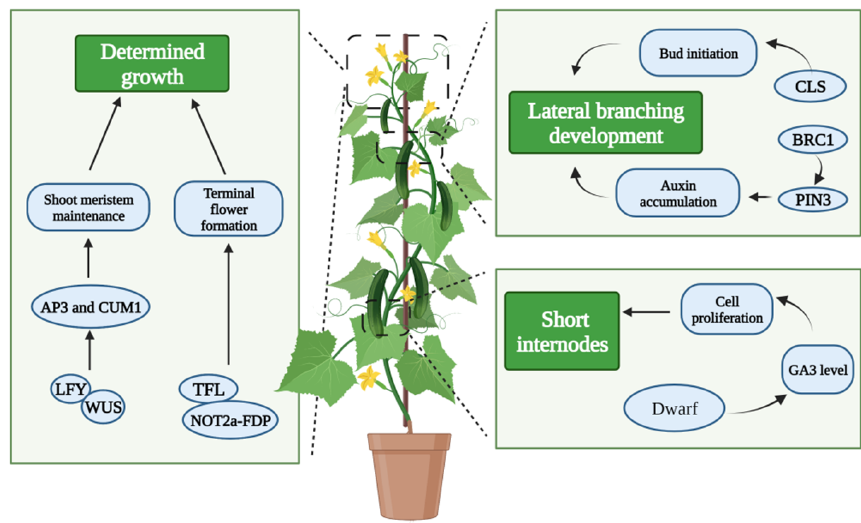
Figure 3. Genetic and molecular regulation mechanisms of the cucumber plant architecture. TFL1’s interaction with CsNOT2a-CsFDP impedes terminal flower formation, and LFY interacts with CsWUS to regulate shoot meristem maintenance in cucumber via activating CsAP3 and CsCUM1 to regulate cucumber towards a determined growth pattern. BRC1 regulates lateral branching by influencing auxin accumulation, while CLS influences bud initiation. Dwarf regulates the internodes by the regulation of endogenous GA3 levels and cell counts in the main stem. Abbreviations in figure, LFY: LEAFY; AP3: APETALA3; CUM1: Cucumber MADS box gene 1; TFL: Terminal Flower1; NOT2a-FDP: Negative on TATA less2-FD Paralog; BRC1: Branched1; CLS: Cucumber Lateral